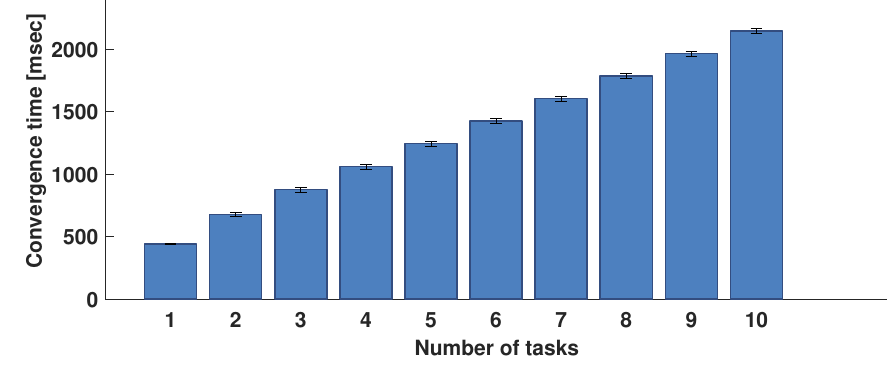
Figure 9. Average values of convergence